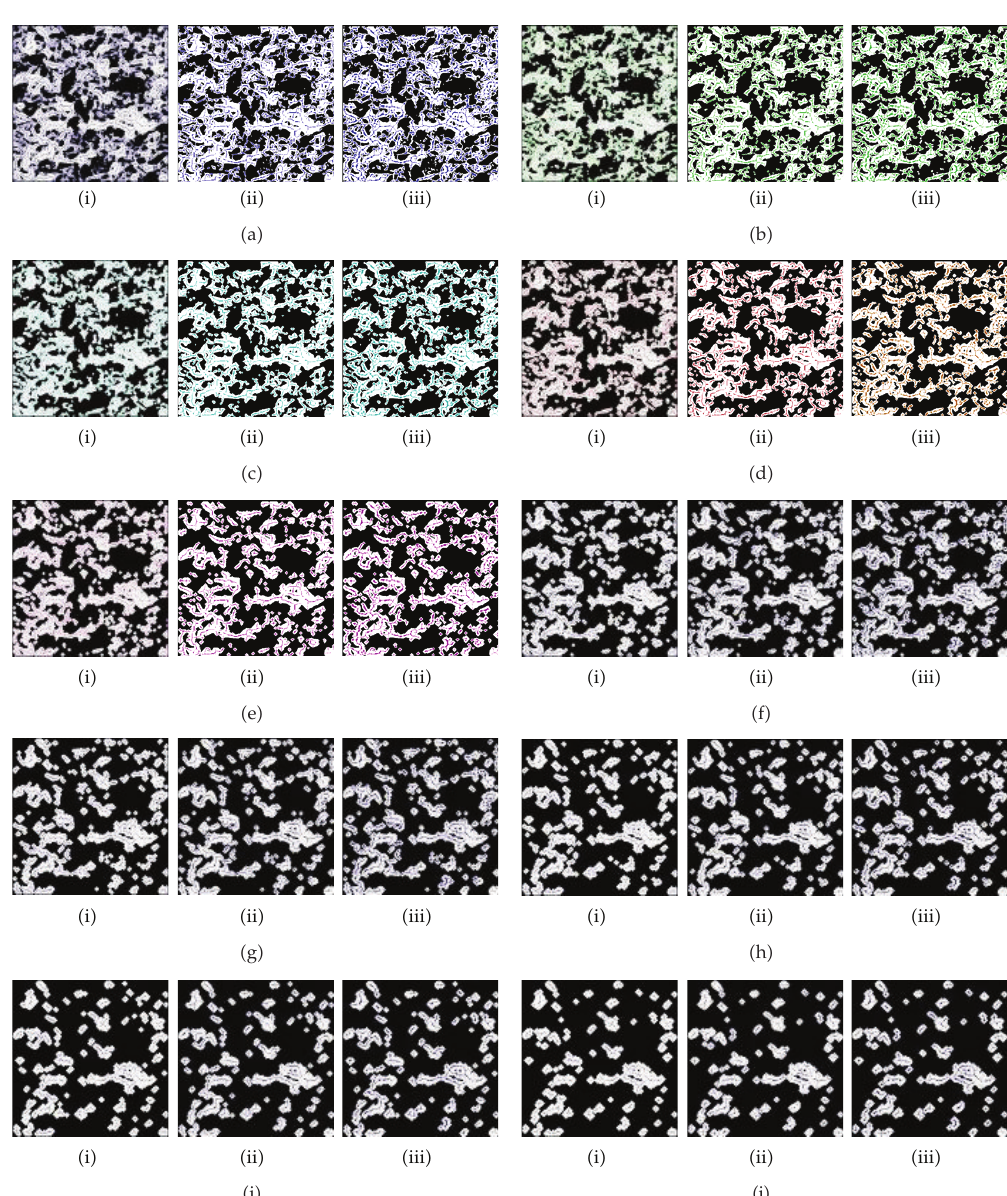
Figure 4: (cid:2) a–j (cid:3) The opening transformations of pore images in Figure 3 (cid:2) a (cid:3) –3 (cid:2) j (cid:3) are used to extract pore connectivity networks by structuring elements (cid:2)(cid:2) i (cid:3) rhombus, (cid:2) ii (cid:3) square, and (cid:2) iii (cid:3) octagon (cid:3)